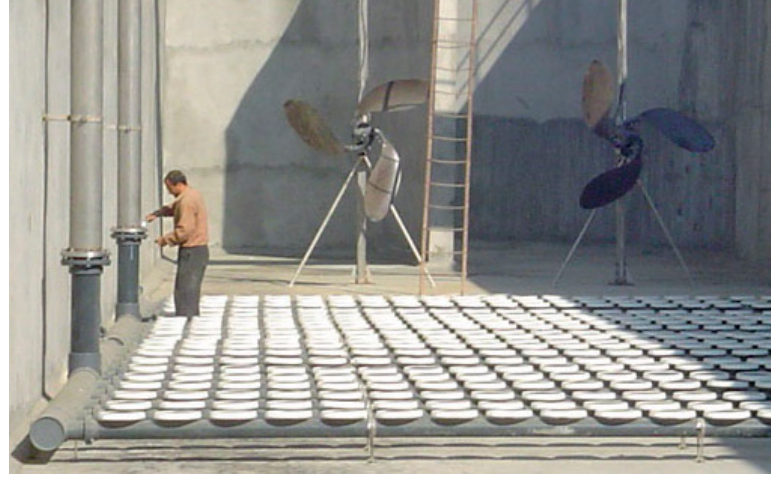
Figure 1. Fixed bottom aeration grid and agitators [5]